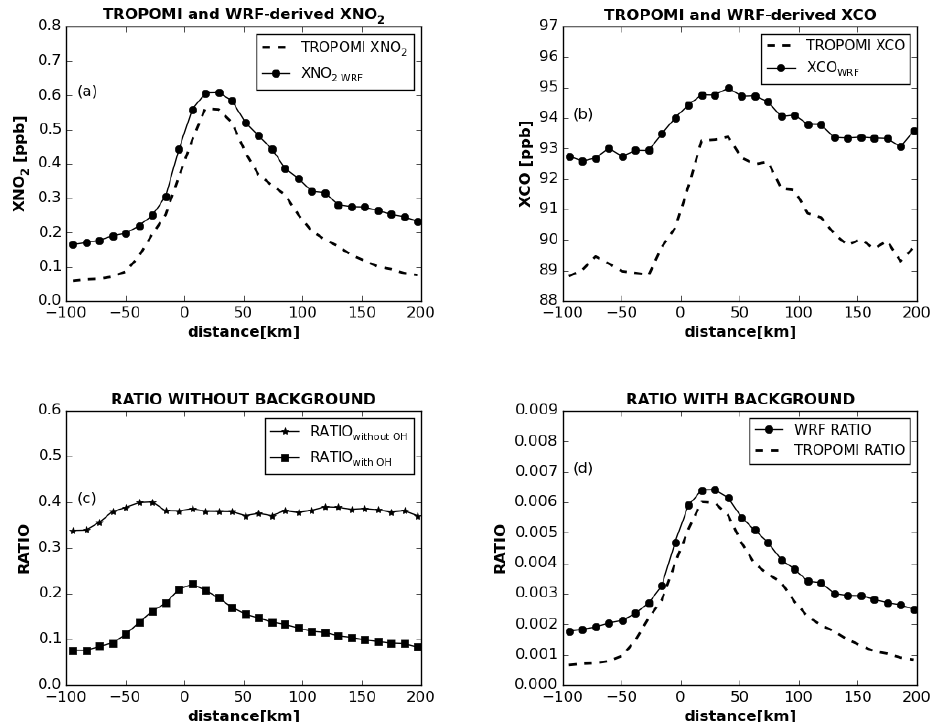
Figure 3. Comparison of WRF and TROPOMI averaged across the wind for each small box (a) XNO 2 , (b) XCO, (c) WRF ratio (XNO 2 / XCO) without CAMS background and (d) WRF ratio (XNO 2 / XCO), with background and TROPOMI as a function of distance to the center of Riyadh for summer (June to October